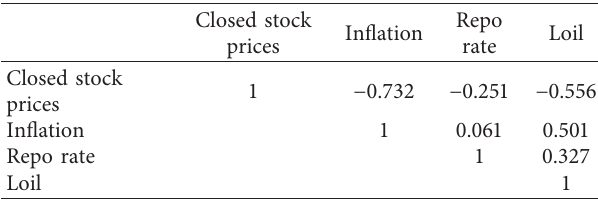
Figure 3: Representing “stock return data” based on RBFNN. Table 2: The correlations between the independent and the de- pendent